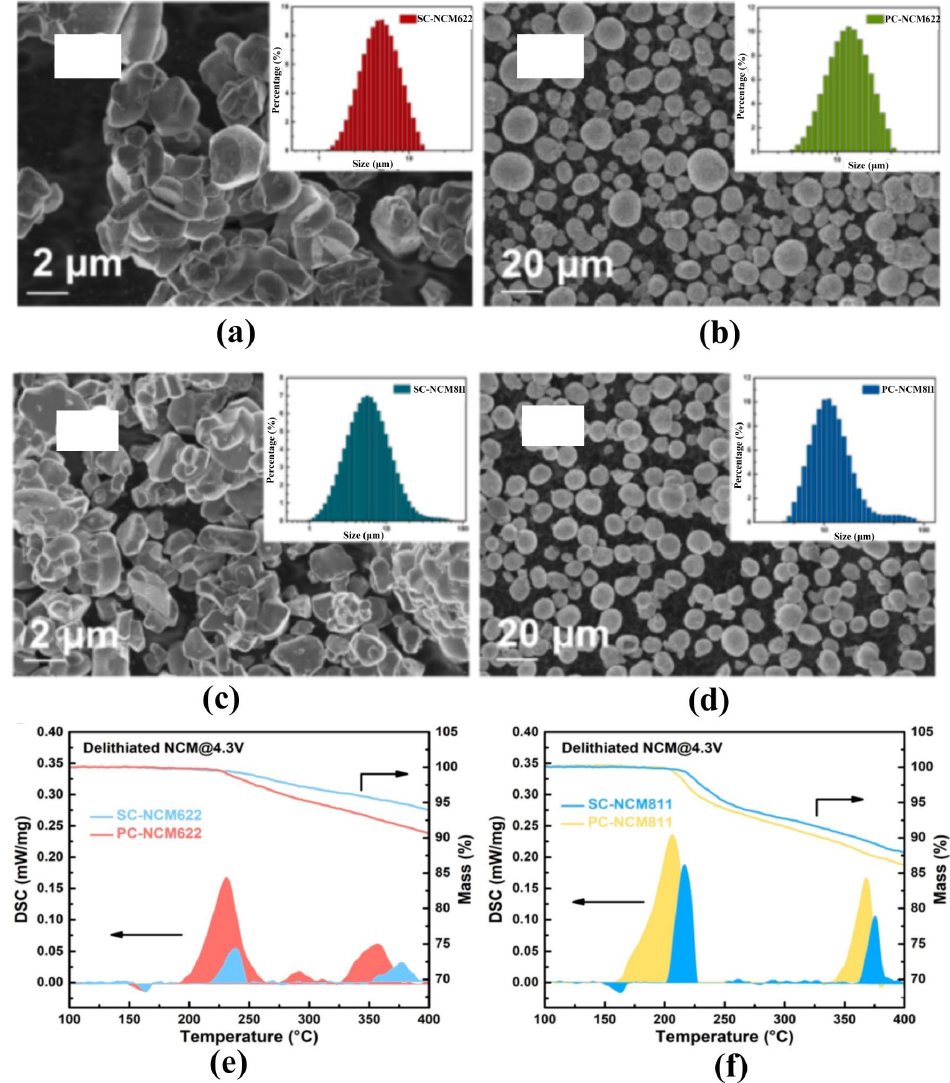
Figure 8. SEM and particle size analyzer test results of ( a ) SC-NCM622, ( b ) PC-NCM622, ( c ) SC- NCM811, ( d ) PC-NCM811, and TG-DSC test results of the above materials ( e ) NCM622 and ( f